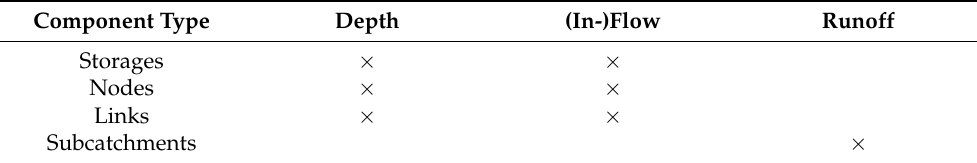
Table 1. Components of the estimated